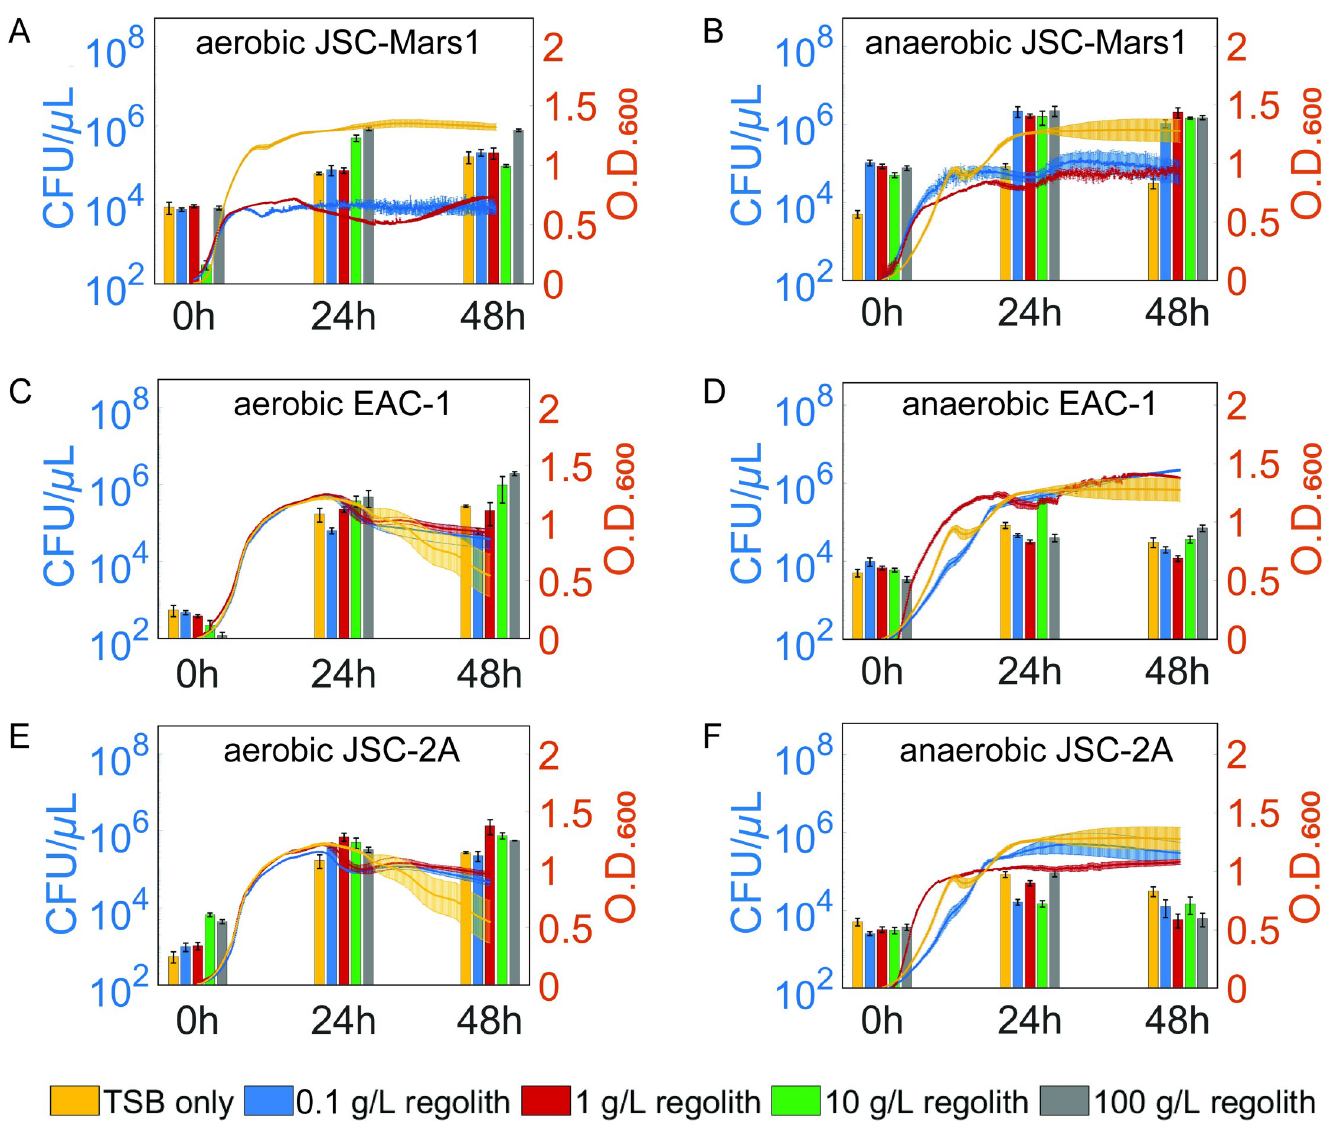
Fig 2. Evaluation of the toxicity of different Lunar and Martian regolith simulants to S . oneidensis under aerobic and anaerobic conditions. Colony forming units (CFU/ μ L) are depicted on the left axis and the O.D. 600 measurements on the right axis. The yellow, blue, red, green, and grey bars represent regolith concentrations of 0, 0.1, 1, 10, and 100 g/L respectively. Optical density at 600 nm of control samples without S . oneidensis were subtracted from the O.D. 600 measurements. The error bars represent the standard error of the mean. Aerobic growth behavior of Shewanella oneidensis was measured in the presence of JSC-Mars1 (A), EAC-1 (C) and JSC- 2A (E), and anaerobic growth of Shewanella oneidensis was measured in the presence of JSC-Mars1 (B), EAC-1 (D) and JSC-2A (F).